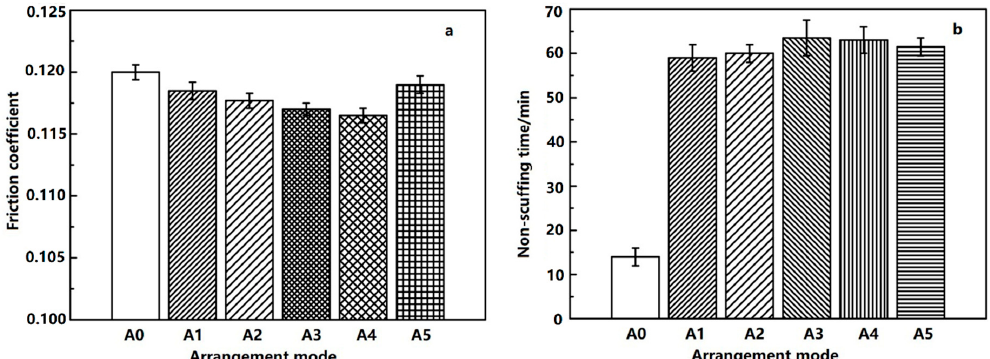
Figure 10. Friction coefficient at the shocking dead center ( a ) and non-scuffing time ( b ) with different micro-dimple arrangements.